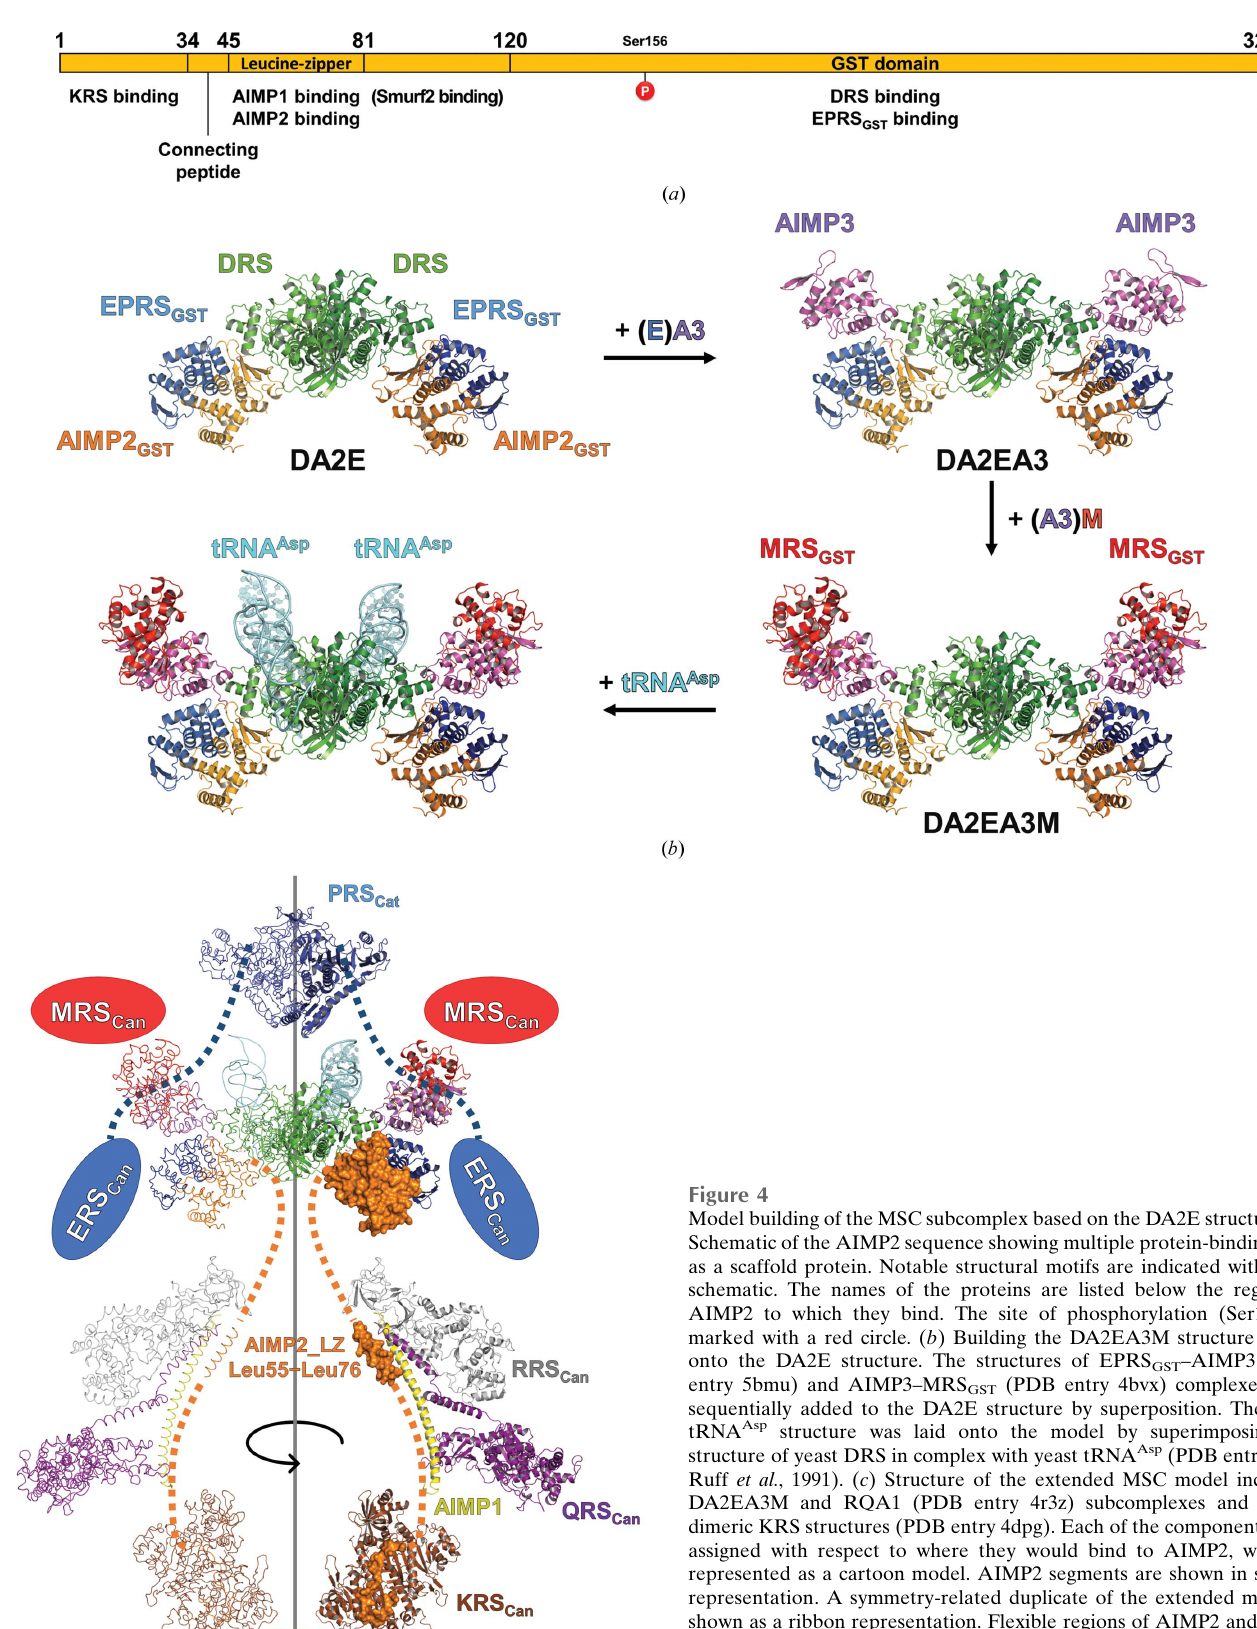
Figure 4 Model building of the MSC subcomplex based on the DA2E structure. ( a ) Schematic of the AIMP2 sequence showing multiple protein-binding sites as a scaffold protein. Notable structural motifs are indicated within the schematic. The names of the proteins are listed below the region of AIMP2 to which they bind. The site of phosphorylation (Ser156) is marked with a red circle. ( b ) Building the DA2EA3M structure model onto the DA2E structure. The structures of EPRS GST –AIMP3 (PDB tRNA Asp structure was laid onto the model by superimposing the structure of yeast DRS in complex with yeast tRNA Asp (PDB entry 1asy; Ruff et al. , 1991). ( c ) Structure of the extended MSC model including DA2EA3M and RQA1 (PDB entry 4r3z) subcomplexes and homo- dimeric KRS structures (PDB entry 4dpg). Each of the components were assigned with respect to where they would bind to AIMP2, which is represented as a cartoon model. AIMP2 segments are shown in surface representation. A symmetry-related duplicate of the extended model is shown as a ribbon representation. Flexible regions of AIMP2 and EPRS are represented by orange and blue dashed lines, respectively. The coloring scheme is as follows: DRS, green; yeast tRNA Asp , cyan; AIMP2, orange; EPRS, blue; AIMP3, violet; MRS, red; RRS, gray; QRS, purple; AIMP1, yellow; KRS,